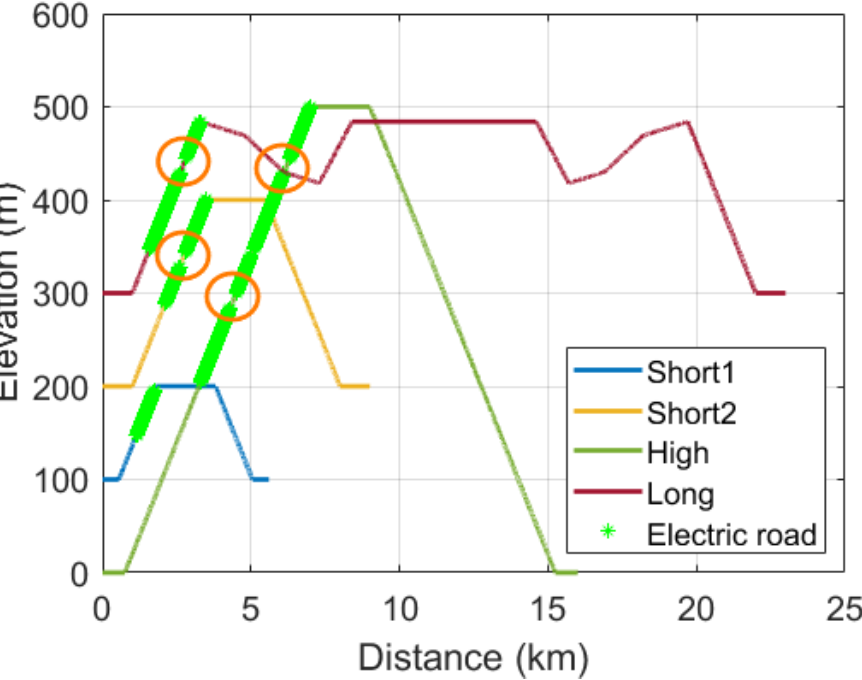
Figure 2. Elevation profiles for the different drive cycles. The lines have been shifted in elevation to minimize overlap. The thick green lines indicate the placement of the electric road. The cycle “Long” represents the special case of transporting waste rock to extend the tailings